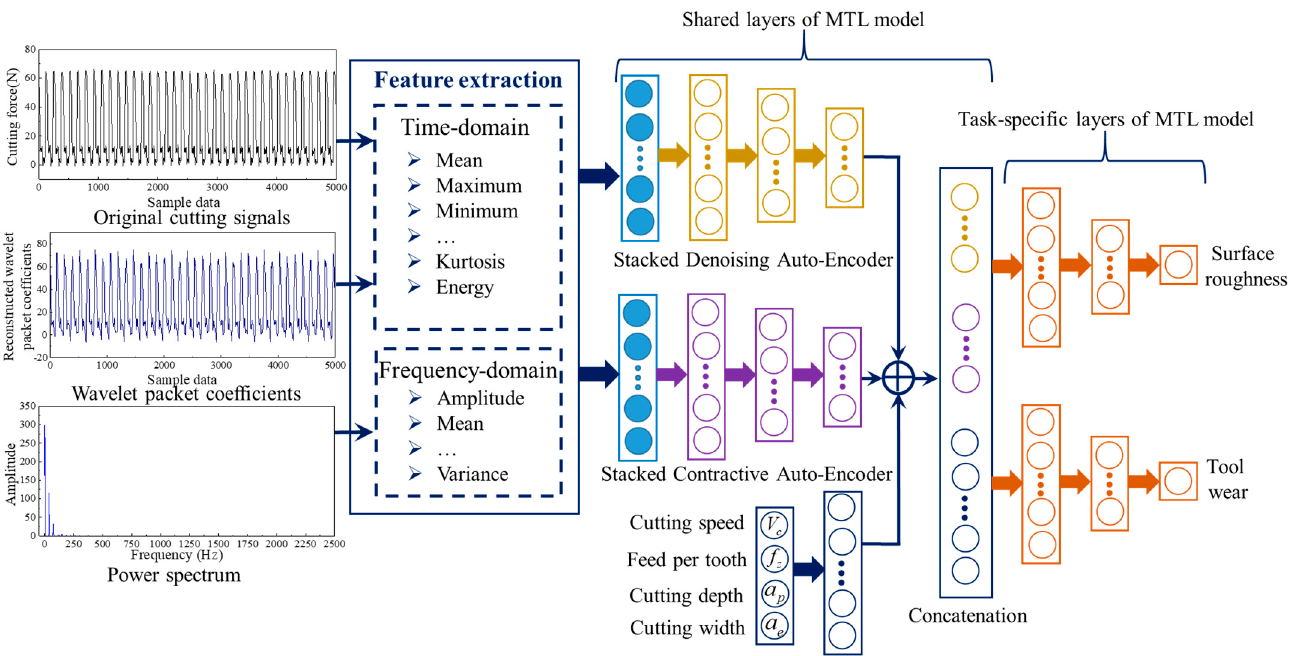
Figure 4. The overall framework of the MTL model.